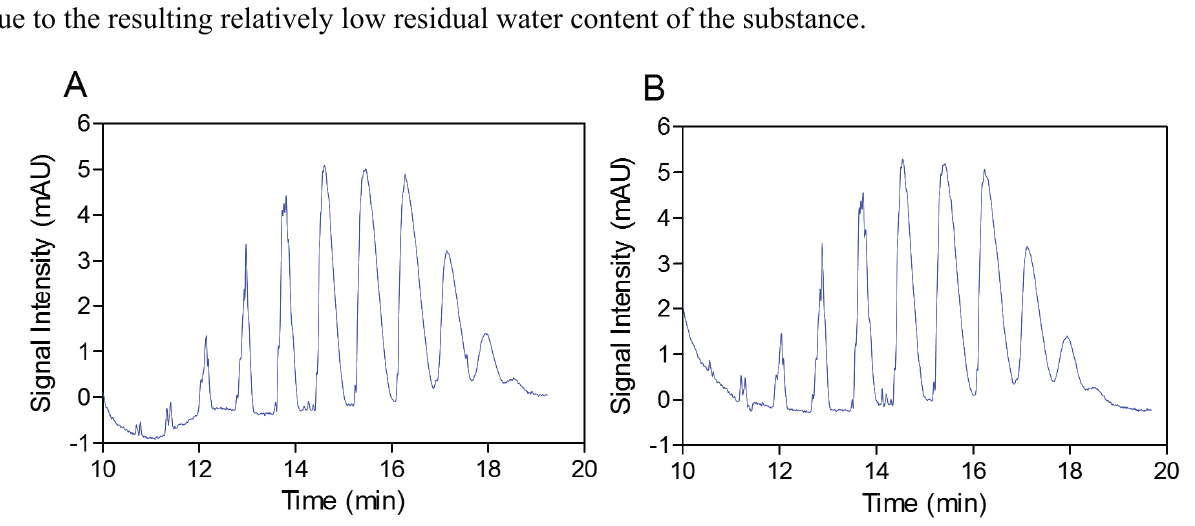
Figure 3. Capillary elecropherograms of the SBE β CD compound ( A ) and SEV-SBE β CD complex ( B ) on a 50 cm, 50 μ m uncoated fused-silica capillary. The signal intensity is measured in milli absorbance units, abbreviated as